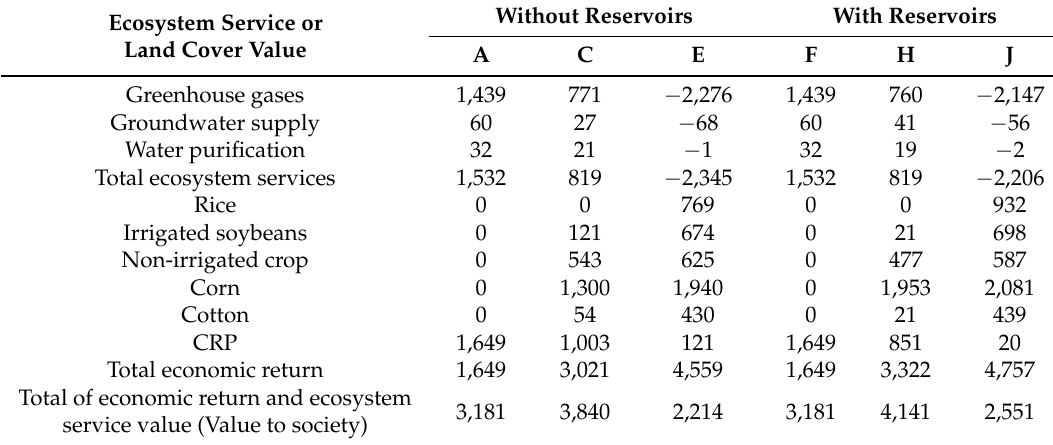
Table 2. Present value of economic returns and ecosystem services for select points on the efficiency frontier using all ecosystem service value (in millions of 2013 constant dollars). Without Reservoirs With Reservoirs Ecosystem Service or Land Cover Value A Greenhouse